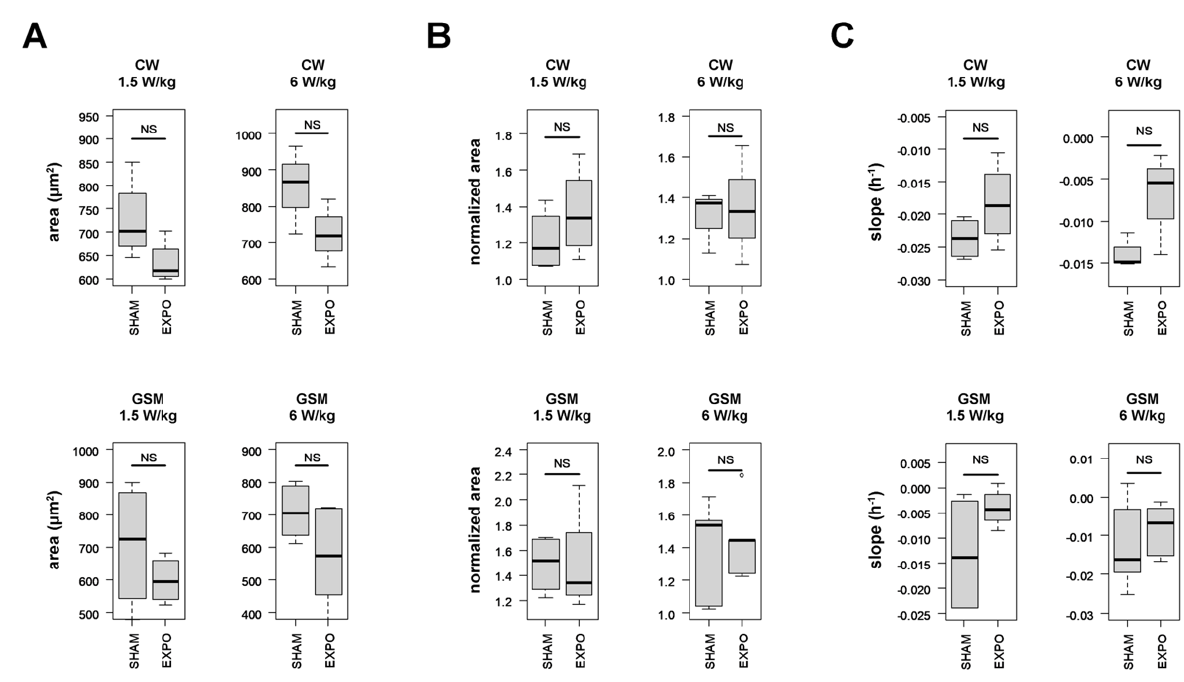
Figure 5. Statistical analysis of the effect of CW (upper panels) and GSM (lower panels)—modulated 1800 MHz signals emitted at either 1.5 or 6 W/kg on the average cell area measured during the last four hours before serum deprivation ( A ), the relative magnitude of the autophagic response during the 6 h following serum deprivation ( B ), and the cell death rate in the last 20 h of the experiments ( C ). Three to four biological replicates were performed for each experimental condition. NS: the difference is not significant between ”SHAM” and “EXPO” conditions.